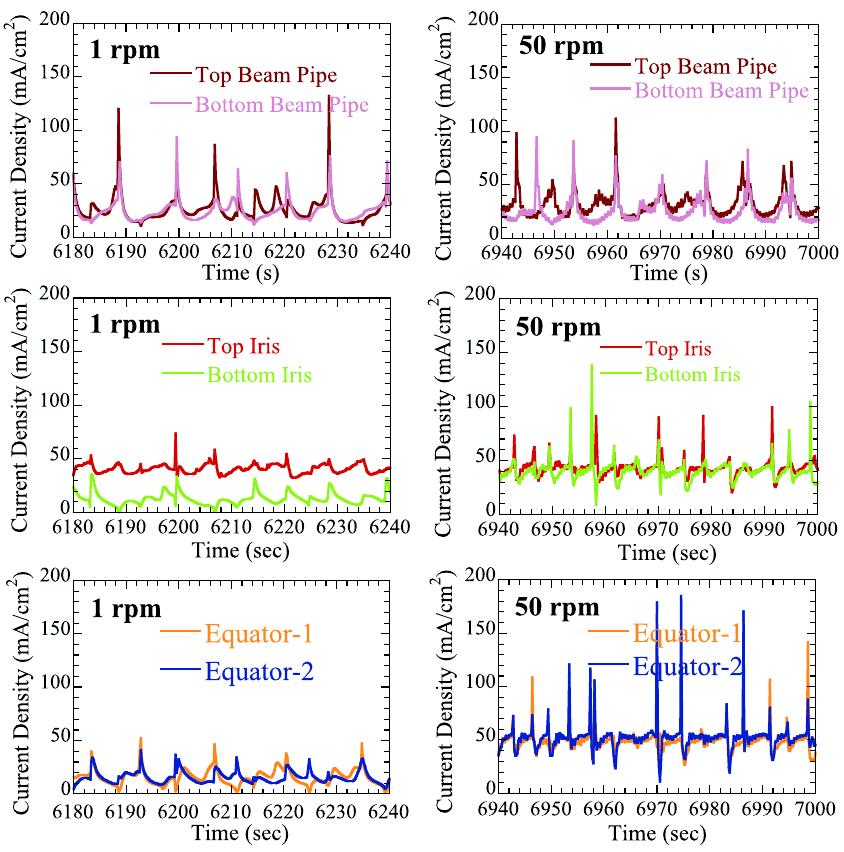
FIG. 15. Coupon current densities with NC-2 at rotation speeds of 1 and 50